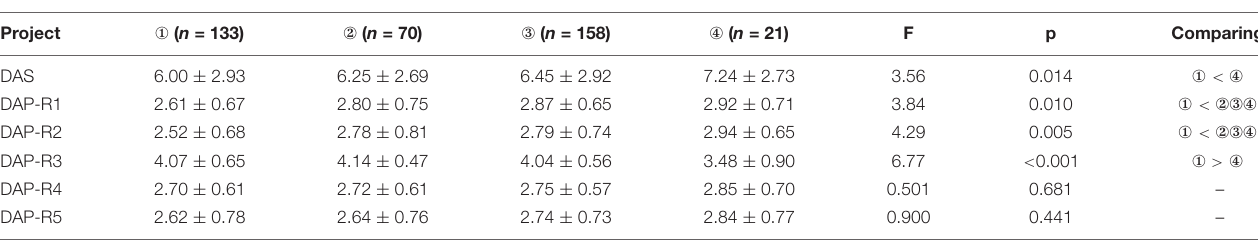
TABLE 5 | Statistical results of different the way families talked about death.